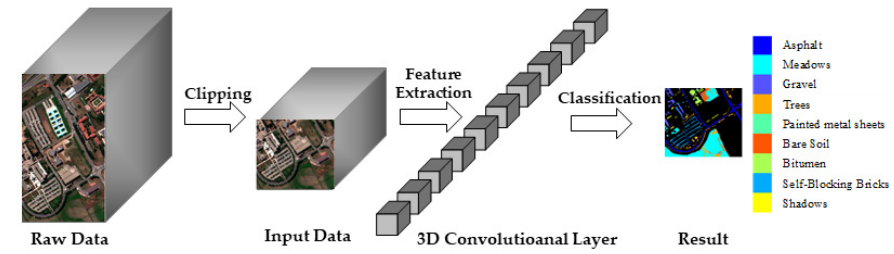
Figure 2. HSI Classification Process Based on 3DCNN.